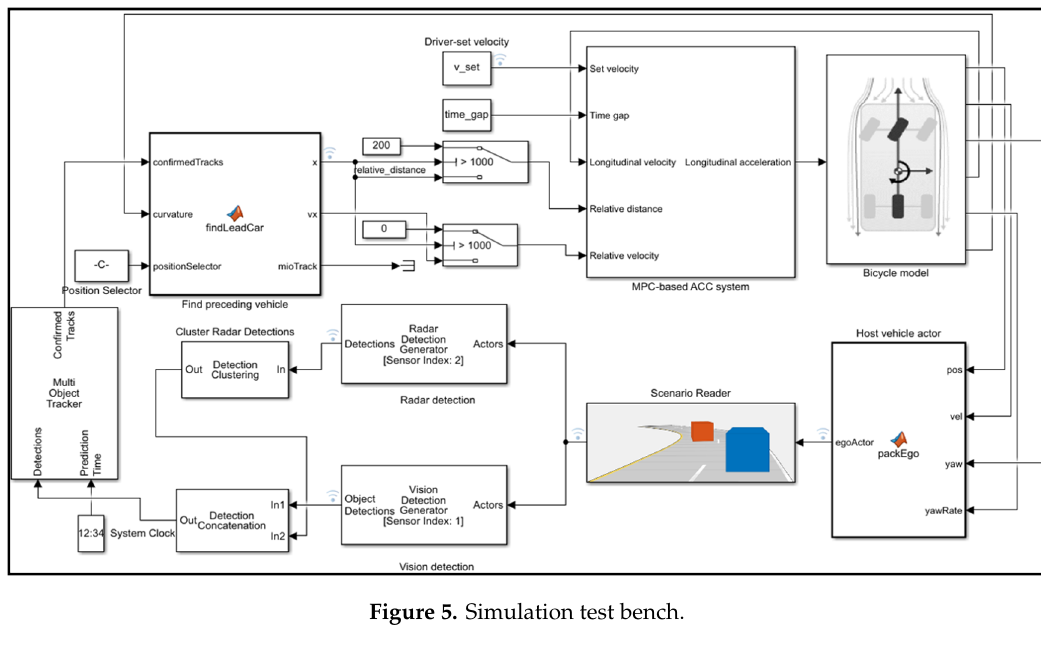
Figure 5 . Simulation test bench . Figure 5. Simulation test bench. Appl. Sci. 2020 , 10 , x FOR PEER REVIEW 11 of 18